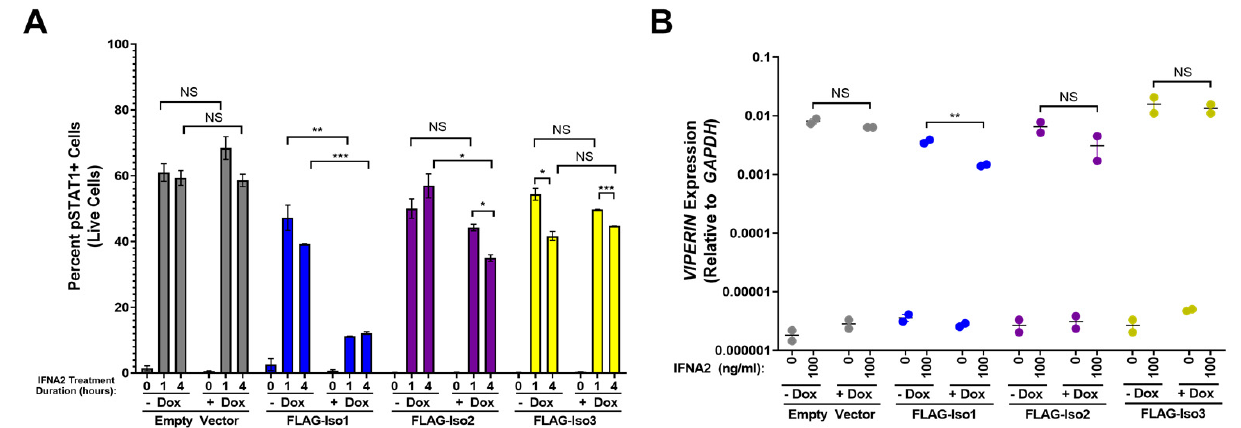
Figure 9. Overexpression of FLAG-Iso1 partially reduces the cellular response to the type-I IFN lig- and IFNA2. ( A ) Quantitation of percent pSTAT1+ in HEK293T-EV and FLAG-IFNLR1 isoform cells after 0, 1, and 4 h of IFNA2 treatment (100 ng/mL) (representative data, two independent experi- ments). ( B ) HEK293T stable lines were ±dox (100 ng/mL) treated for 24 h, then mock or IFNA2 (100 ng/mL) treated for 24 h, then harvested for qRT-PCR analysis of VIPERIN and GAPDH (representa- tive data, two independent experiments). Statistical significance represented by bars and asterisks reflect comparisons between the indicated conditions. Error bars represent standard error of the mean. * = p < 0.05, ** = p < 0.01, *** = p < 0.001. NS = not significant.